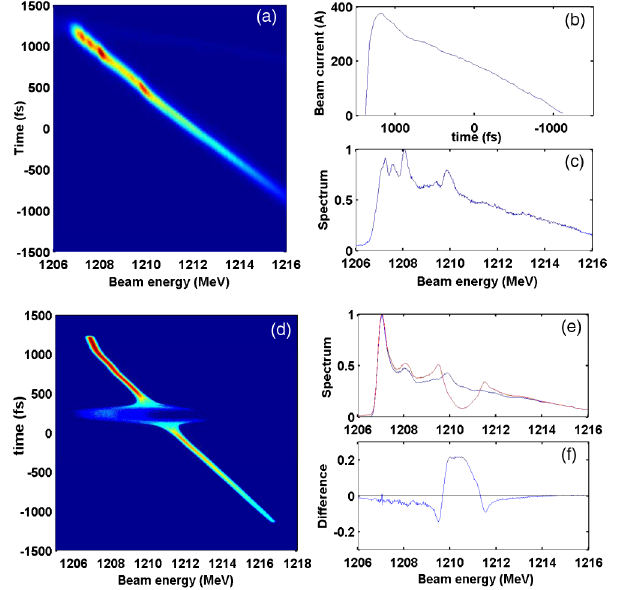
FIG. 3 (color online). Images of the electron beam [(a) and (c)] and corresponding spectrum [(b) and (d)] measured at MBD in the absence [(a) and (b)] and in the presence of the seed [(c) and (d)]. A hole in the electron-beam distribution is clearly evident at about 1.211 GeV. corresponds to a spatial shift of the hole in the energy spectrum. This property suggests one can obtain a very accurate measurement of the timing jitter between the seed the hole.